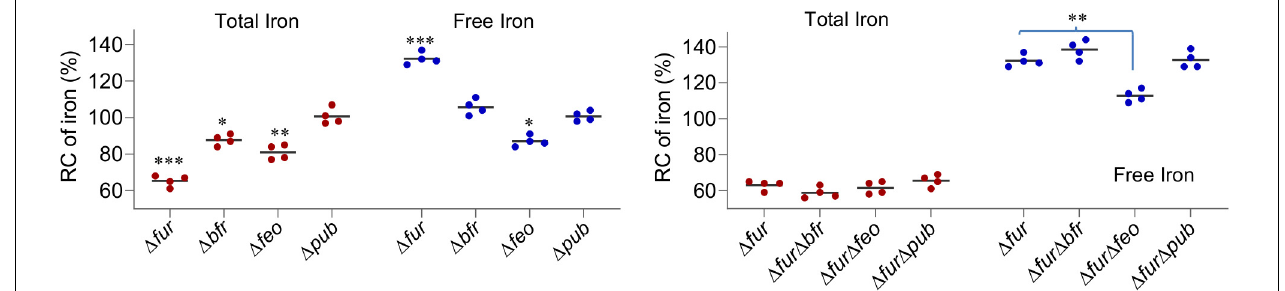
FIGURE 6 | The Feo system has a role in elevated free iron levels caused by the Fur loss. Effects of indicated deletions on cellular iron levels. Cultures of indicated strains entering the stationary phase were collected and their total iron and free iron contents were determined. The averaged levels of WT were set to 100%. Asterisks indicate statistically significant differences of the value compared to that of the WT and between values linked by bracket (* P < 0.05; ** P < 0.01; *** P < 0.001). Experiments were performed at least three times, and data were presented as means ± SEM.